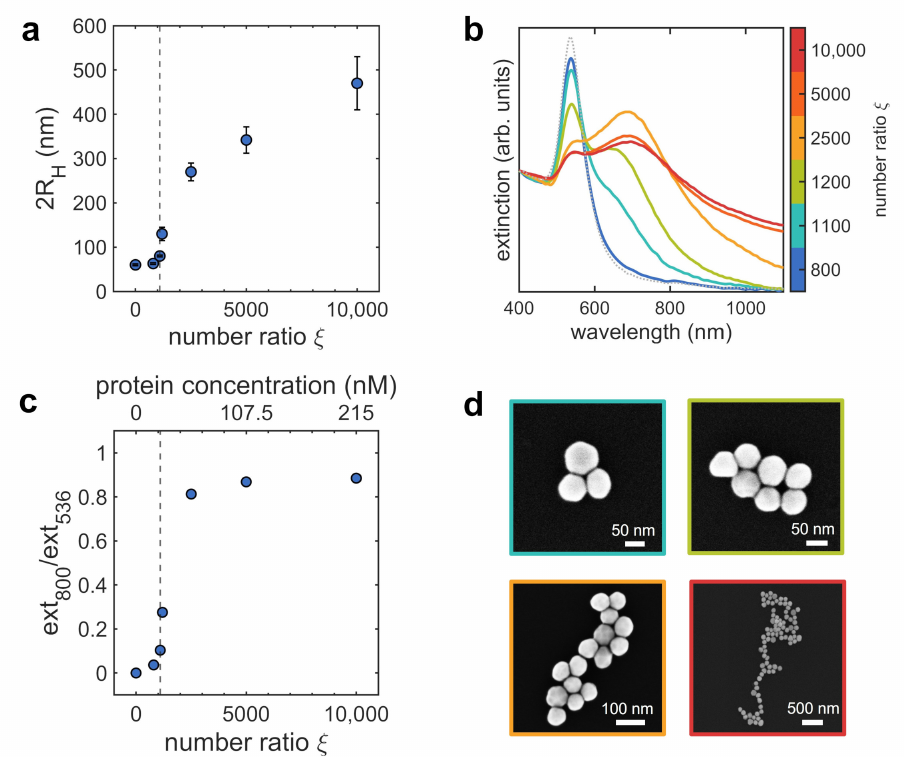
Figure 1. Characterization of AuNPs clusters obtained for different protein concentrations (the lysozyme-AuNPs number ratio ξ is represented by the colorbar), performed at 25 °C and pH 6.5: morphology and optical properties. ( a ) hydrodynamic diameter 2 R H , values and errors are the mean and the standard deviation of at least 3 measurements; ( b ) extinction spectra, the spectrum of bare AuNPs is shown by dashed gray line for comparison; ( c ) calibration curve obtained for protein concentration: the experimental parameter employed for quantifying the aggregation of AuNPs, namely the ratio between the extinction values measured at 800 and 536 nm, is reported as a function of protein concentration. The vertical dashed lines in panels a and c indicate the onset of the aggregation. ( d ) Representative SEM images of clusters for ξ = 1100, ξ = 1200, ξ = 2500 and ξ =